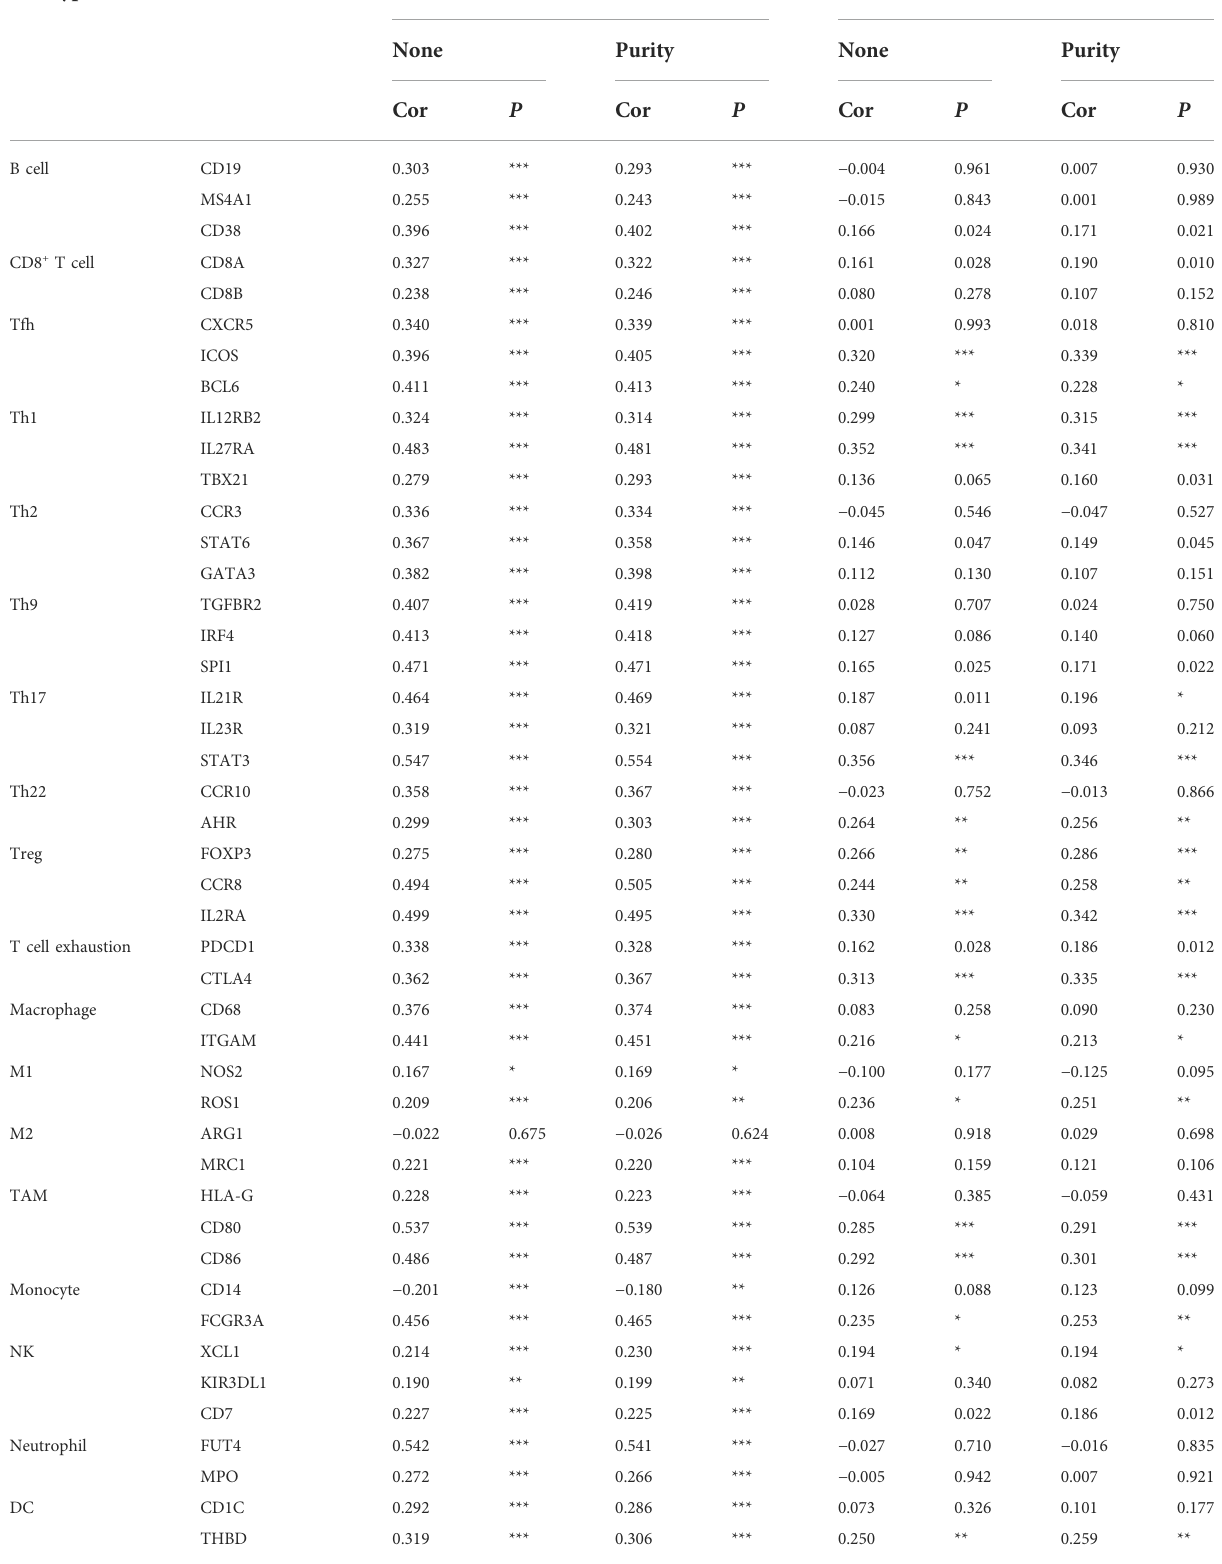
TABLE 1 Correlations between WTAP and gene markers of immune cells in LIHC and